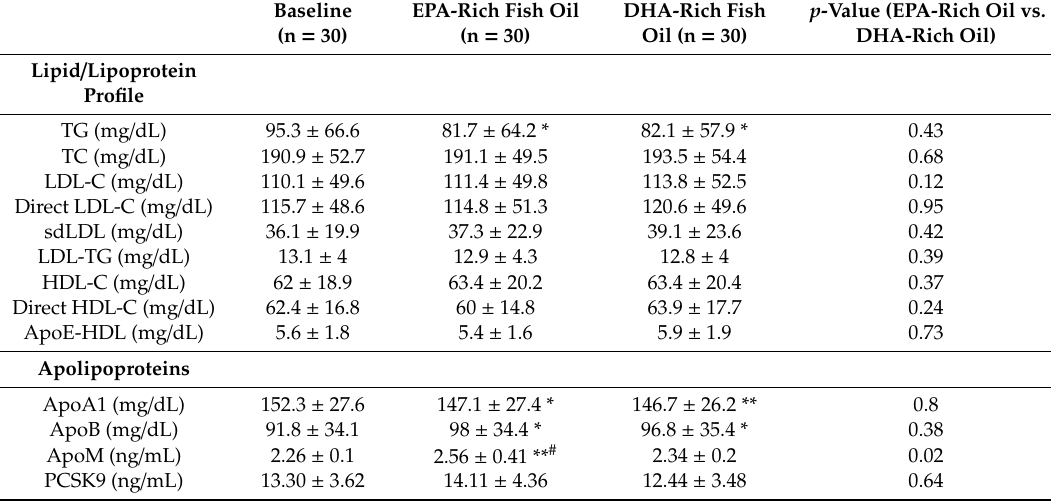
Table 4. Lipoprotein biomarker values before (baseline) and after an 8-week ingestion of EPA-rich or DHA-rich fish oil